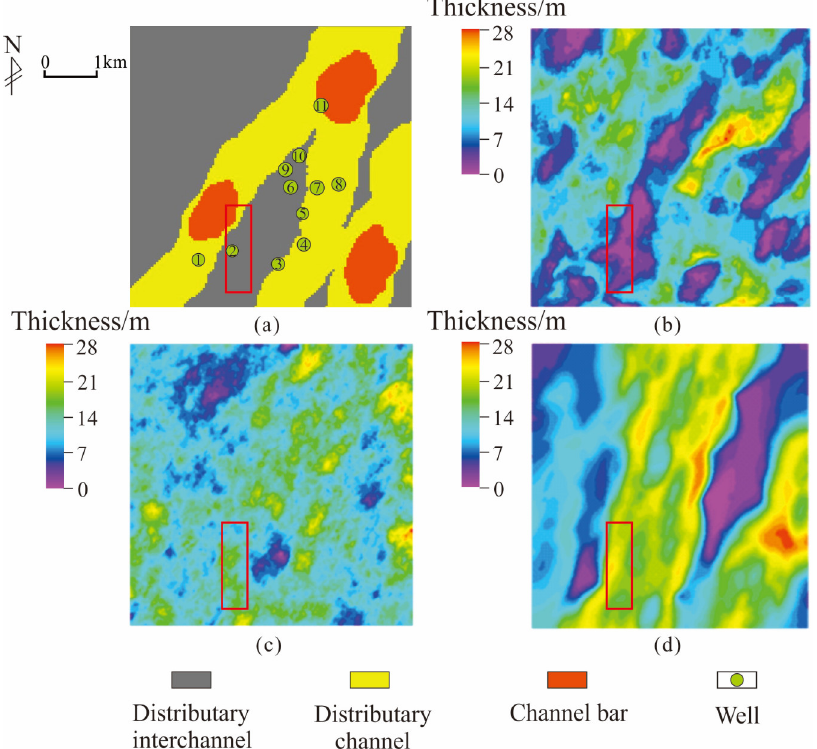
Figure 14. Thickness distribution results of sandbody in P 2 h 8 member corresponding to different methods. The part of the red box clearly shows the difference of the simulation results of the three methods. ( a ) Distribution of plane sedimentary facies of P 2 h 8 member; ( b ) MPS result based on 2D TIs; ( c ) SIS result; ( d ) object-based simulation result.